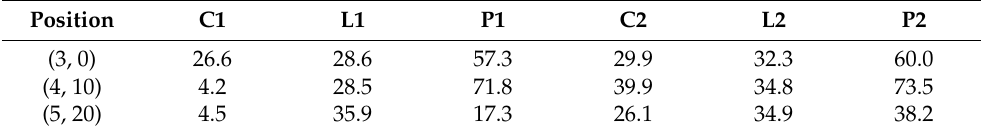
Table 2. Mean value of pixels outside the